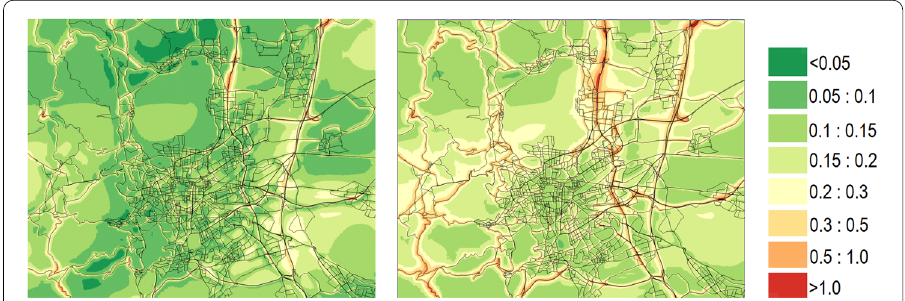
Fig. 9 Relative mean errors (%) mapped over the meta-model domain compared to the full model solution, for parameters over the month of November 2014. Left: projected NO 2 concentration field. Right: emulated NO 2 concentration field